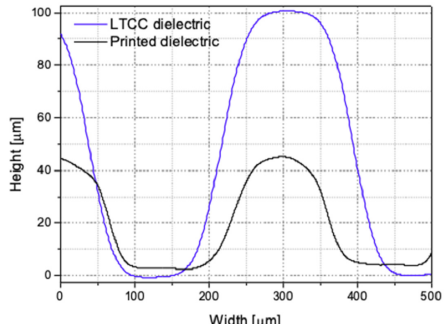
Figure 10. Surface topography profiles of LTCC readout boards manufactured with two